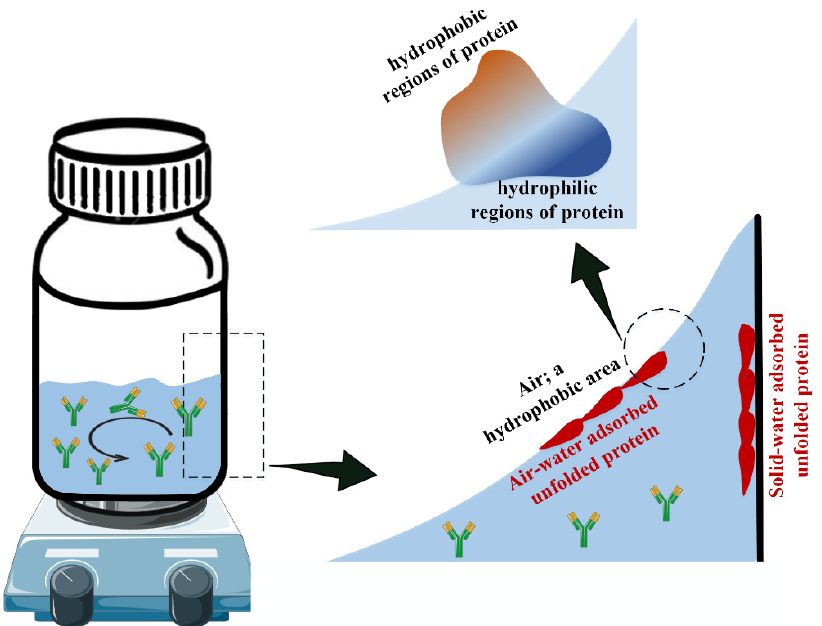
Figure 5. Agitation-induced protein unfolding/aggregation (the concepts were inspired by